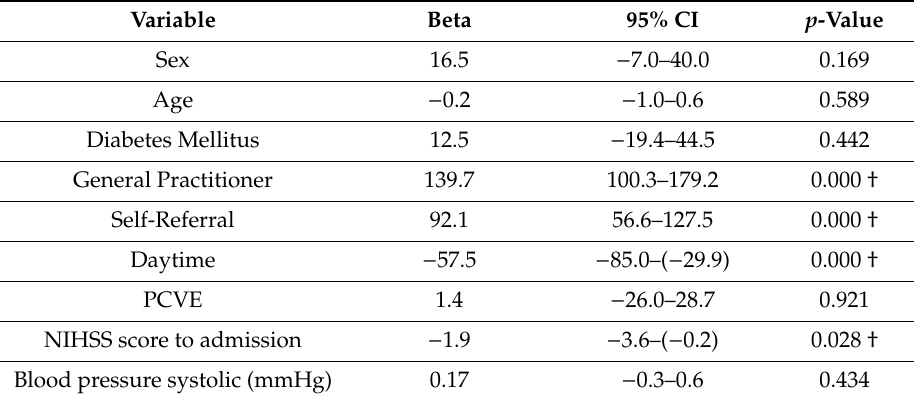
Table 2. Factors associated with time to admission (linear regression